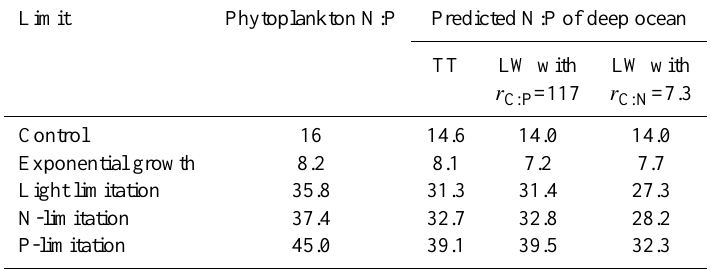
Table 2. Limits on ocean composition predicted from theoretical limits on the N:P stoichiometry of phytoplankton (Klausmeier et al., 2004) using the TT and LW models, and assuming in the latter that phytoplankton N:P is the N:P threshold that triggers N 2 -fixation. Limit Phytoplankton N:P